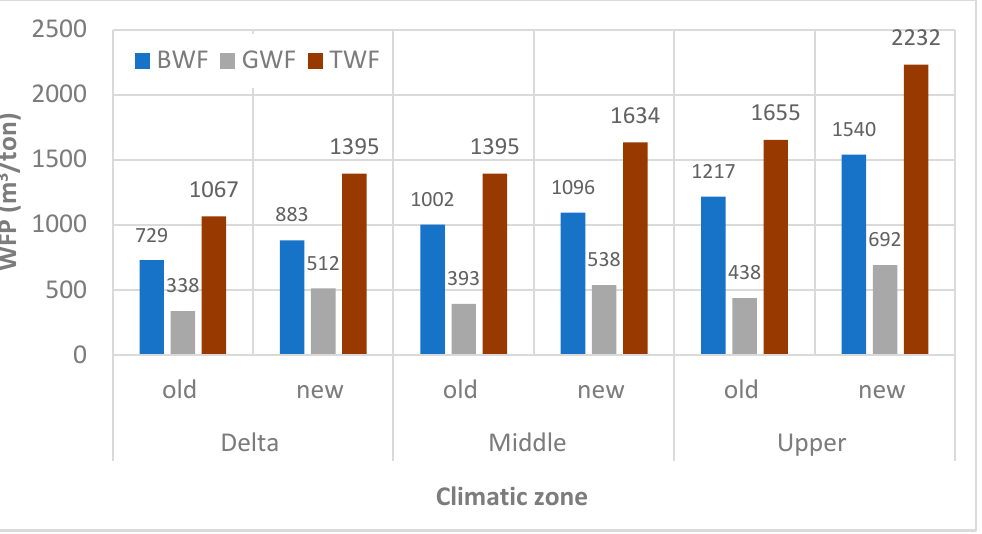
Figure 8. Blue, grey, and total water footprints for maize for three agro-ecological zones and two soil types, i.e., old and new land.